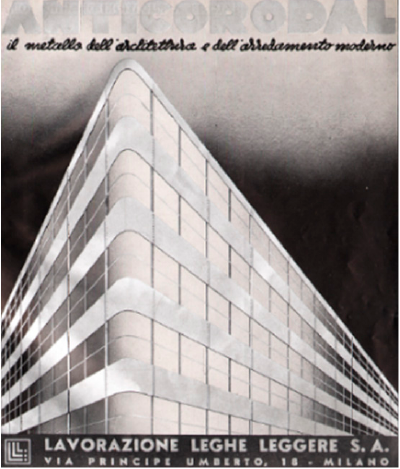
Figure 6. Advertising of L.L.L. (Lavorazione Leghe Leggere) company. Anticorodal. Image from Casabella (1936).